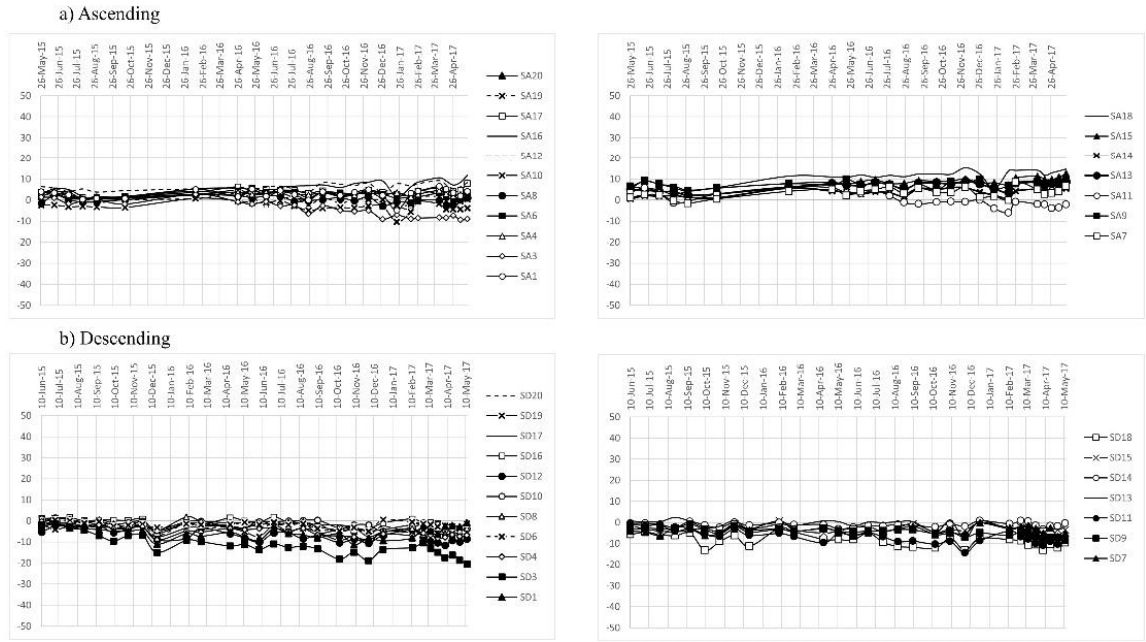
Figure 5. Cumulative LOS displacements between May 2015 to May 2017 gathered by Sentinel ( a )ascending and ( b )descending within Goddard landslide extent.